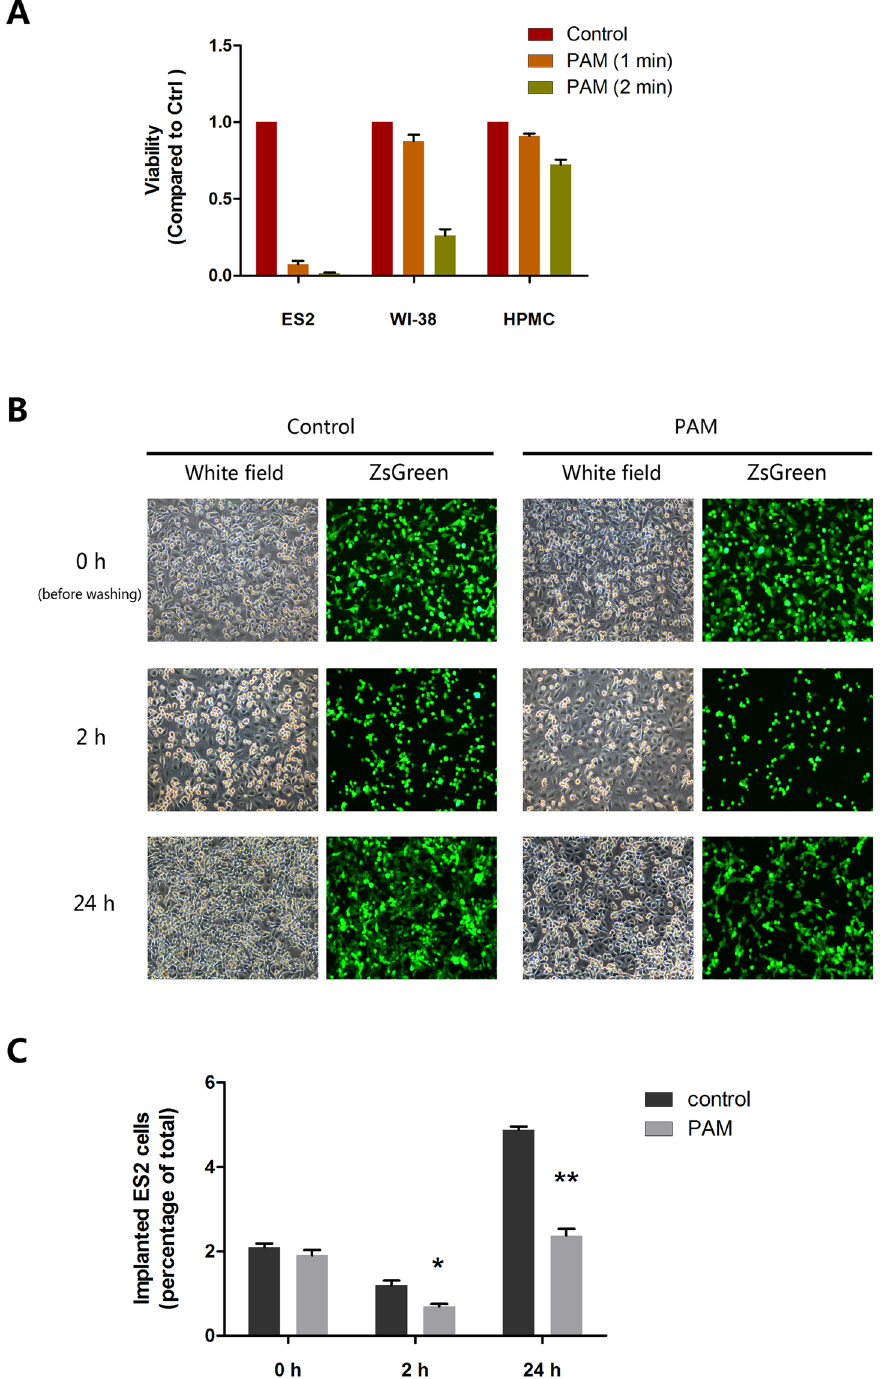
Figure 3. Plasma-activated medium (PAM) prevents ES2 cell plantation on co-culture with human peritoneal mesothelial cells (HPMCs). ( A ) Selective cytotoxicity of PAM against cancer cells when compared with HPMCs and lung fibroblast cells (WI-38). Cell viability was compared to that in the control group. ( B ) The co-culture model reflects the situation of peritoneal metastasis of ovarian cancer. After washing, ES2 cells (ZsGreen marked) implanted onto the monolayer of HPMCs was calculated in both the control and PAM groups. Three representative fields are captured and calculated. Data are presented as mean ± SD. Statistics are shown as * P < 0.05, ** P <